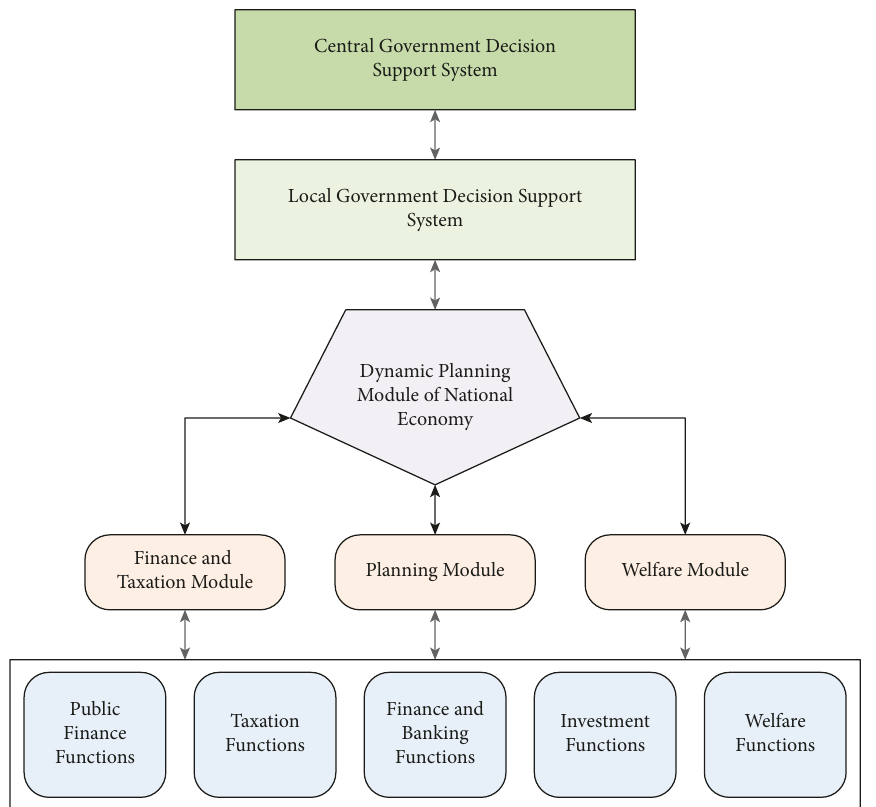
Figure 10: Structure of government decision support system (source: Guangzhou Milestone Software Co., Ltd., China).